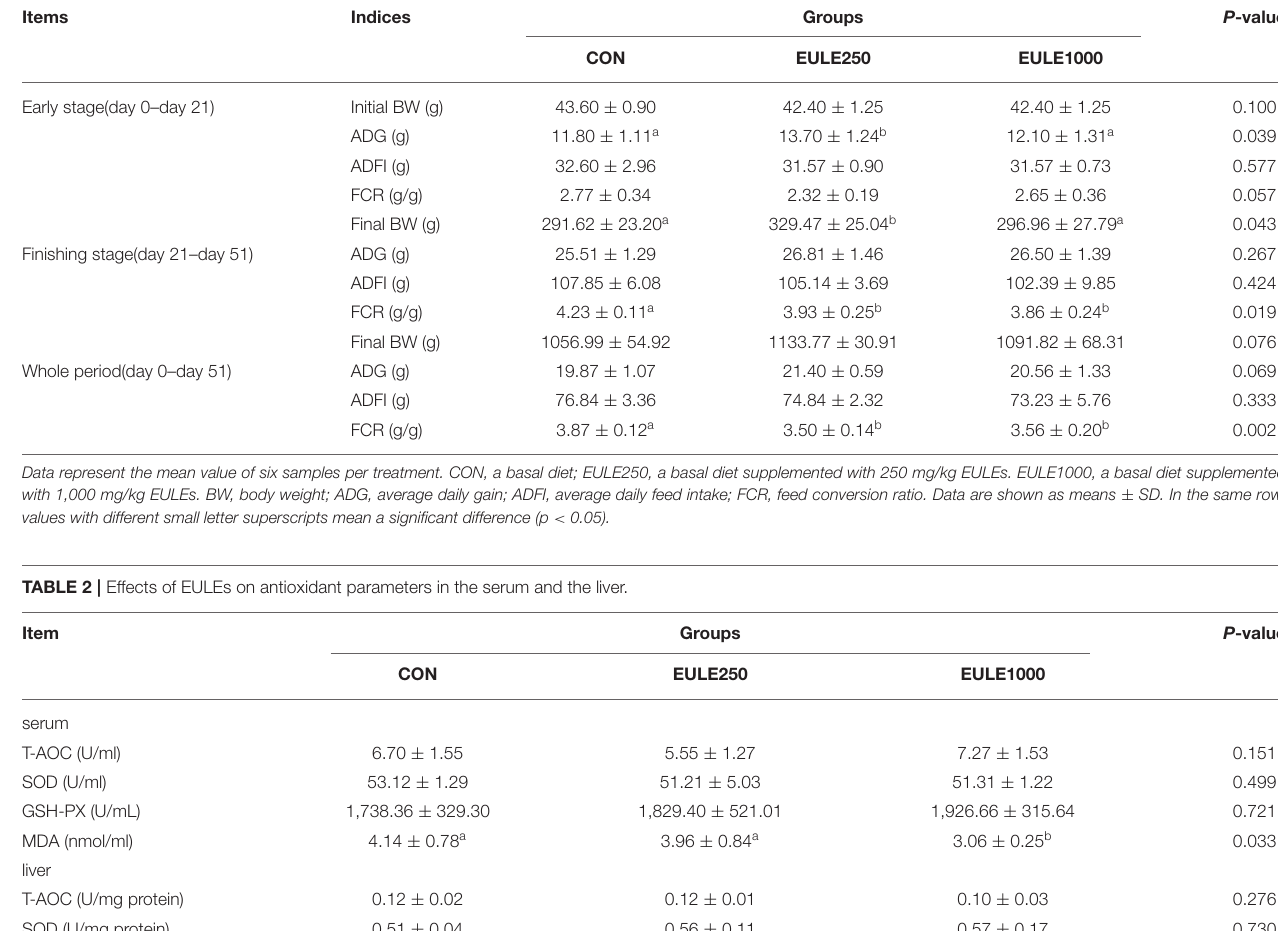
TABLE 1 | Effects of Eucommia ulmoides leaf extracts (EULEs) on the growth performance of broilers. Items